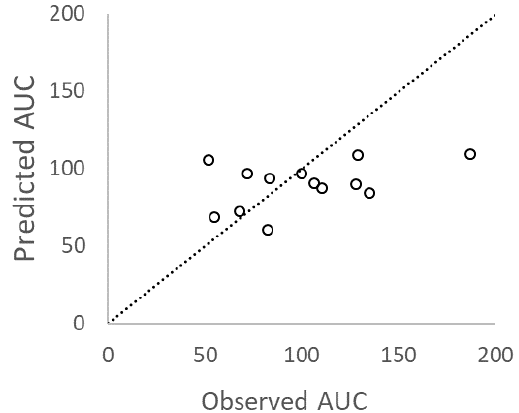
Figure A1. An example of polymyxin B AUC correlation: predictions were based on the Sandri model [12] (highest correlation of the 5 models); r 2 = 0.197. The dashed line depicts the line of identity, y = x.